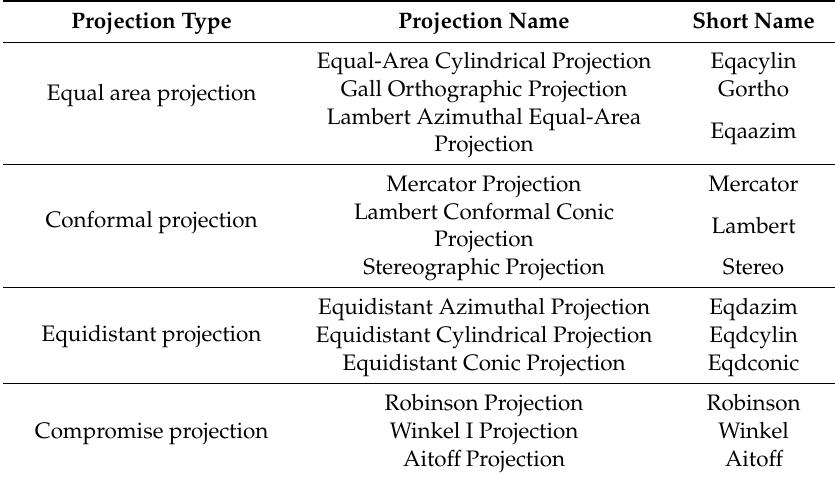
Table 4. Map projections.